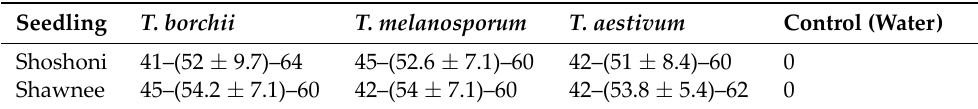
Table 4. Percentage of pecan mycorrhization assessed 12 months after the inoculation with Tuber borchii , T. melanosporum , T. aestivum or control (water) a .